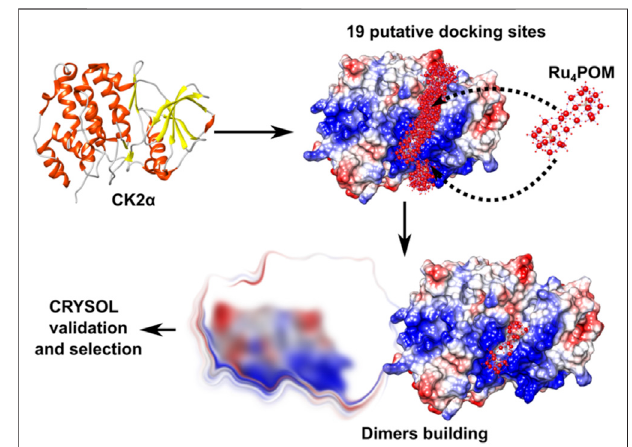
FIGURE8| StrategyformodellingtheCK2 α -Ru 4 POMdimer.Dockingof Ru 4 POM to CK2 α generated 19 putative CK2 α -Ru 4 POM docking models. Each model was processed with Symmdock to obtain 100 possible dimer con fi gurations. Approximately 1,900 dimeric models were validated using CRYSOL. Finally, only dimers stabilized by inter-molecular Ru 4 POM- mediated contacts were selected ( “ selection ” ).